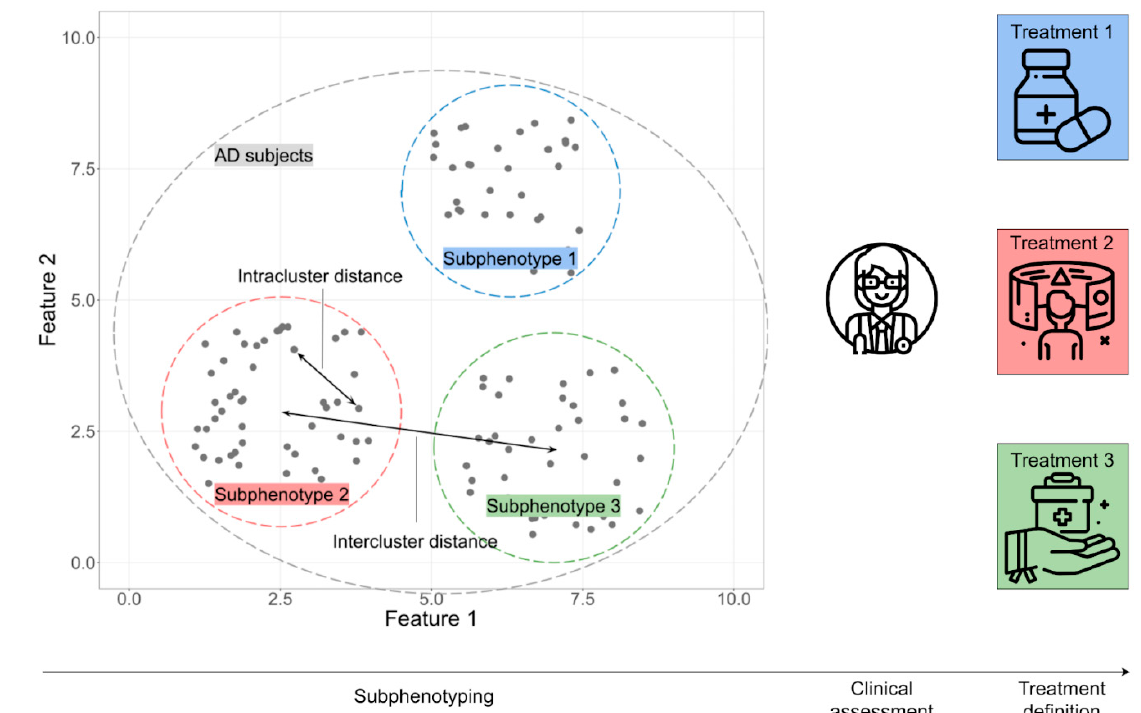
Figure 4. Clustering tools determine groups that share similar properties among populations. Each cluster defines a sub-phenotype with its own peculiar characteristics, providing fine-grained information for the stratification of patients; clustering minimizes the intra-cluster distance, while maximizing the inter-cluster distance. Clinician assessment is pivotal in the development of individually-tailored treatments.